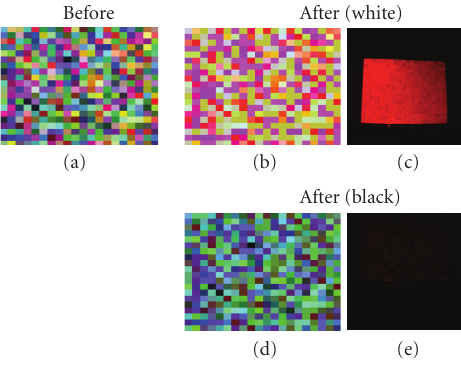
Figure 5: Color conversion using BBF algorithm. (a) is the randomly generated 400 colors before conversion. (b) and (d) are the (a) image after converted to the white and black set, respectively. (c) and (e) are the blank surface seen by the synchronized camera when image (b) and (d) are being projected,